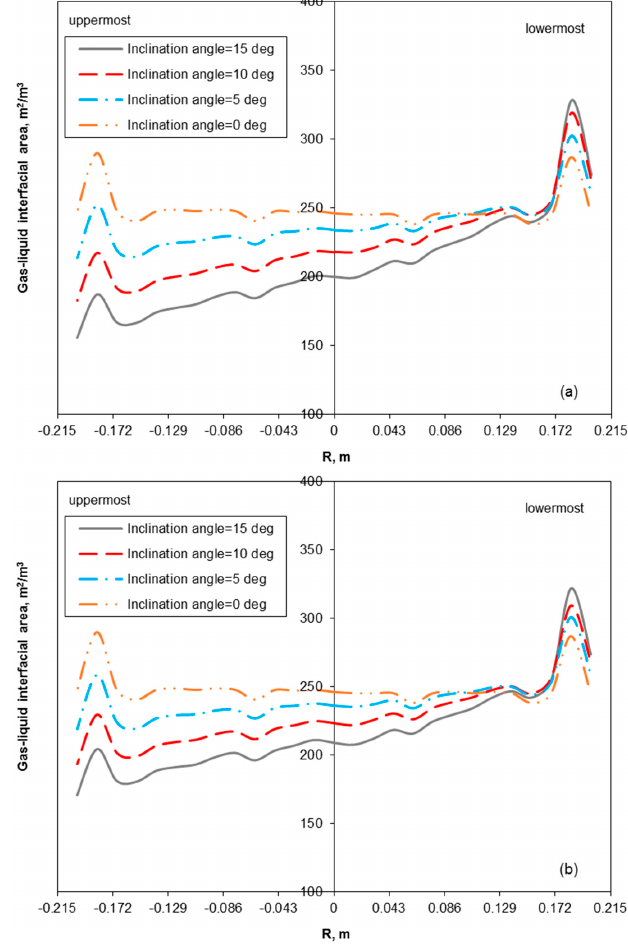
Figure 13. Steady-state radial profiles of gas-liquid interfacial area in x -axis (see Figure 1)—vertical and inclined seawater scrubbers (Packed-bed column with Raschig super-Rings; H = 5 m; z/H = 0.8): ( a ) Pressure = 1.5 MPa; ( b ) Pressure = 2.5 MPa.